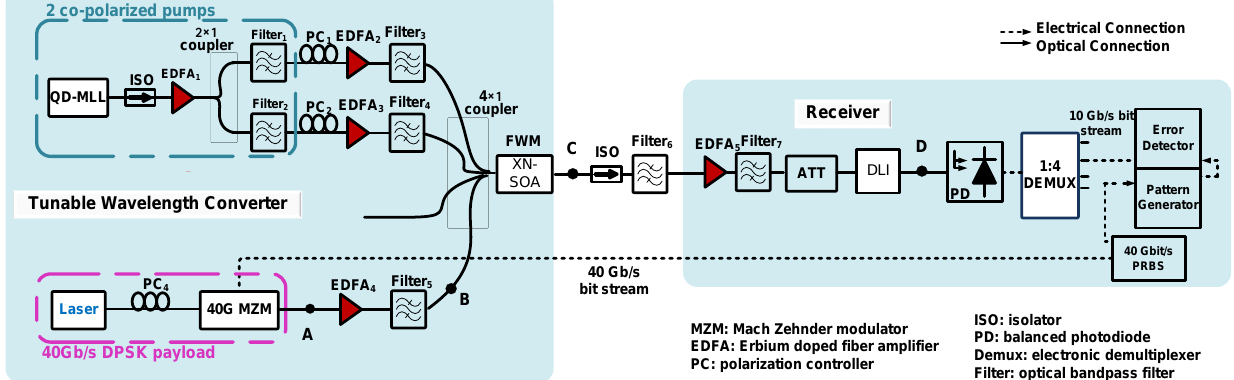
Figure 2. Setup for wavelength conversion of 40 Gbit/s on off keying (OOK) and differential phase-shift keying (DPSK)